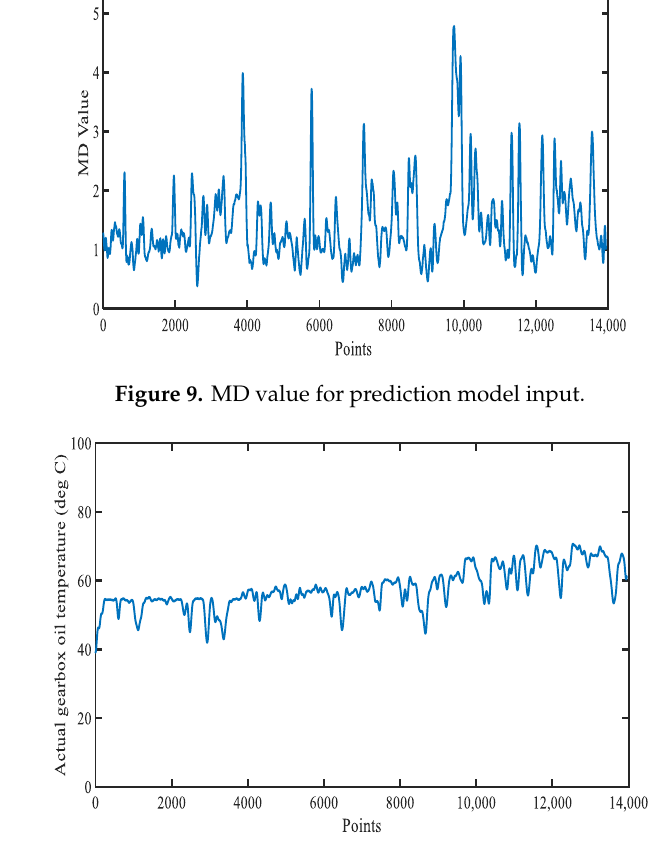
Figure 10. Actual temperature of the gearbox oil obtained from the supervisory control and data acquisition data.